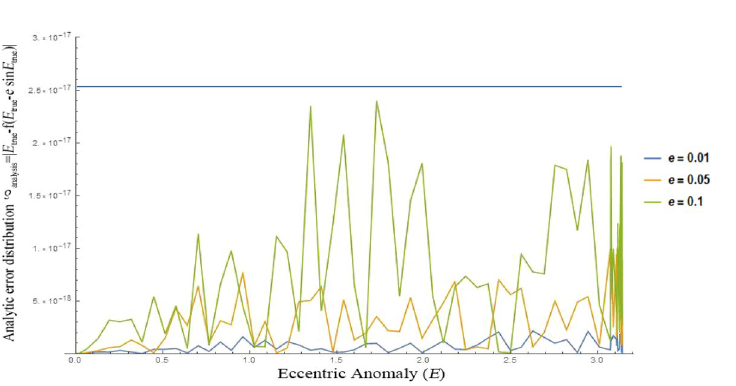
Figure 3. Explicit expression E = f 2 ( M ) of the SICAA method applied to the function f 1 ( M , E ) = E − M − 0.1sin E over the domain M ∈ [0, π ] (top right), matching nearly-circular orbit of eccentricity 0.1. The implicit function contour (top left) of the Kepler’s equation is shown for comparison.